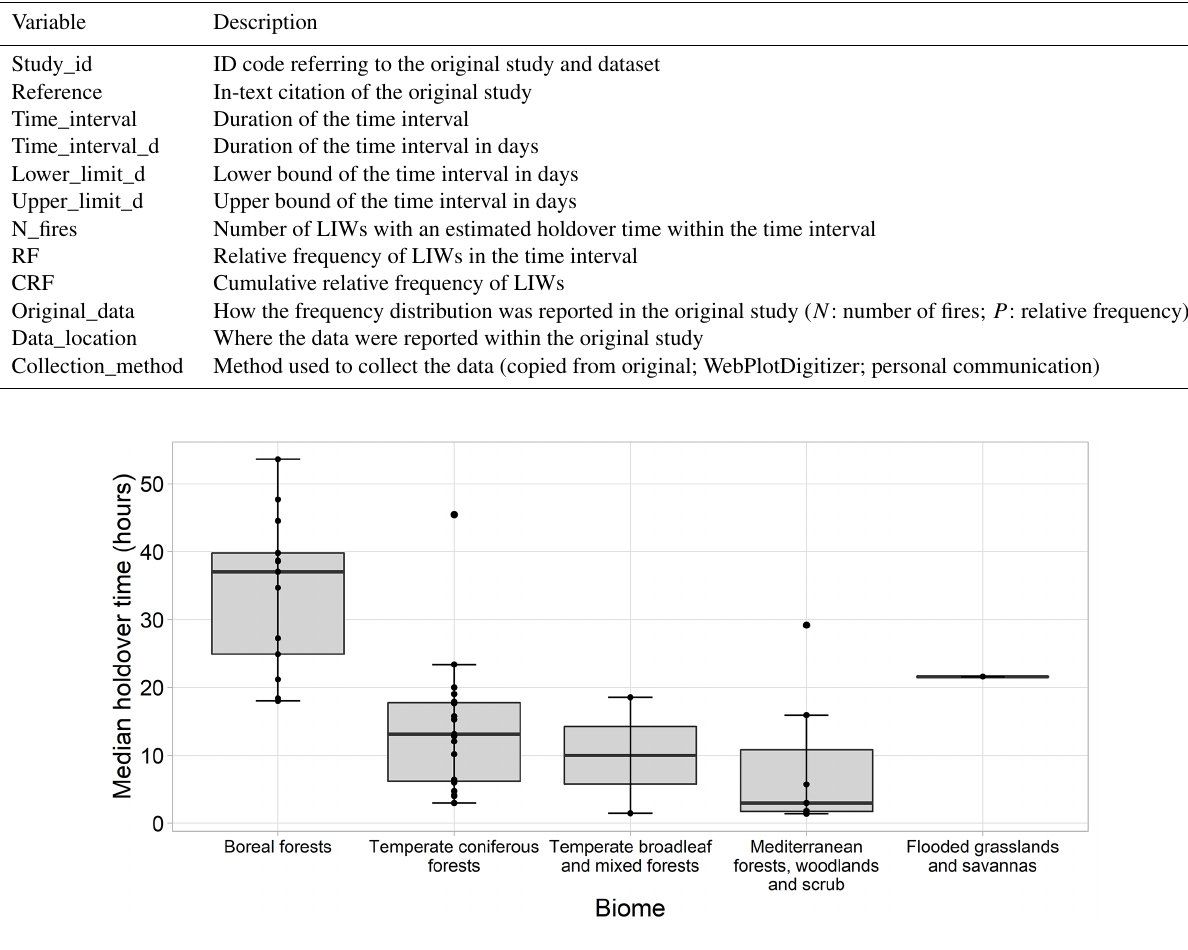
Figure 2. Boxplots of median values of holdover time by biome calculated from the 42 frequency distributions of censored data (Table